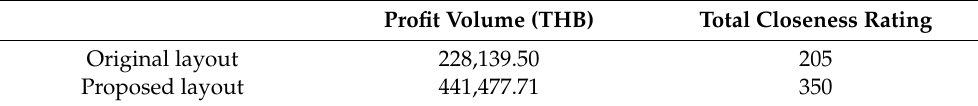
Table 13. Comparison of the execution time of Apriori, FP-Growth, and Prefixspan.